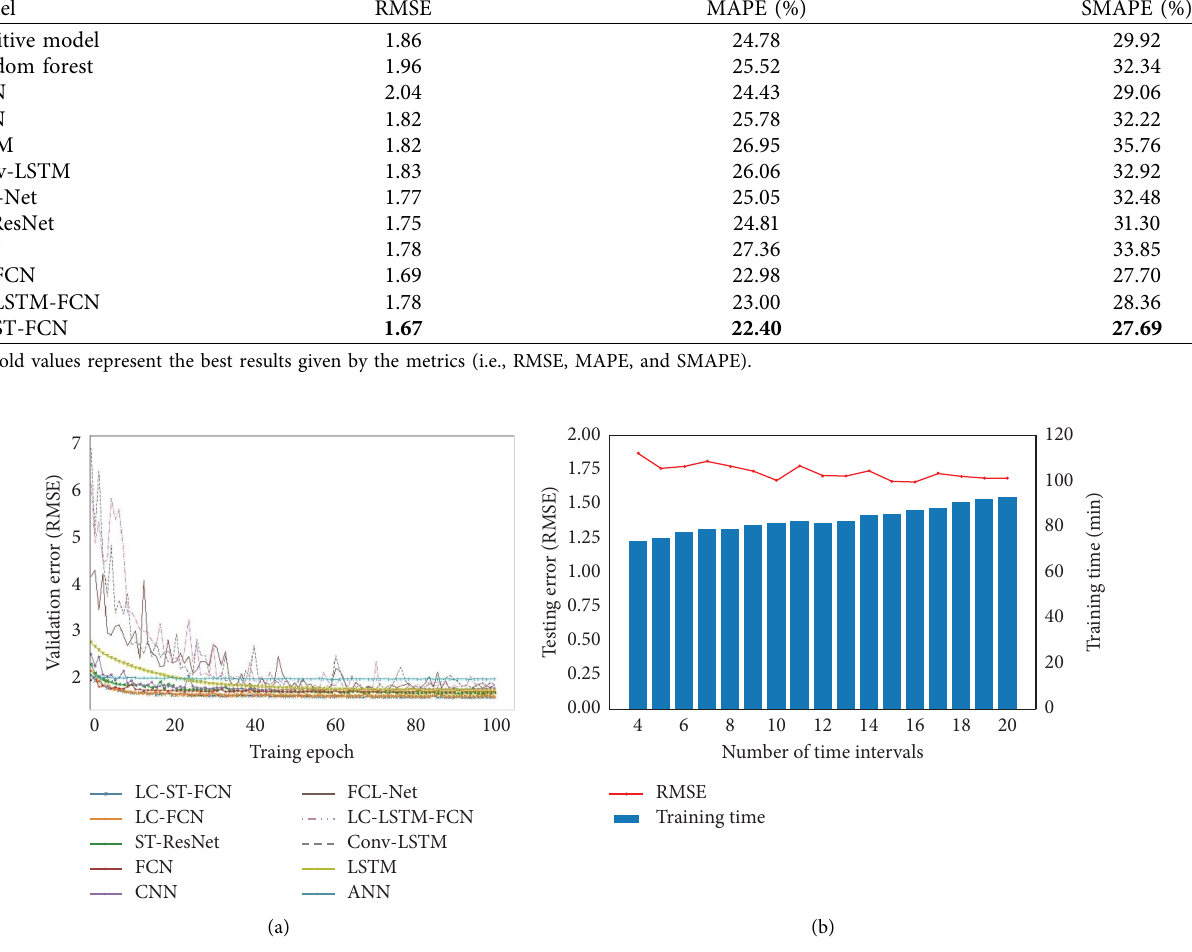
Figure 5: Experimental analysis. (a) Training convergence curves. (b) Sensitivity analysis of τ .